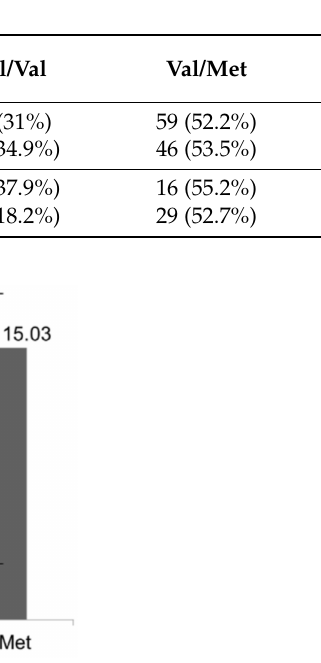
Figure 1. Risk for schizophrenia conferred by T. gondii infection across different COMT Val105/158Met